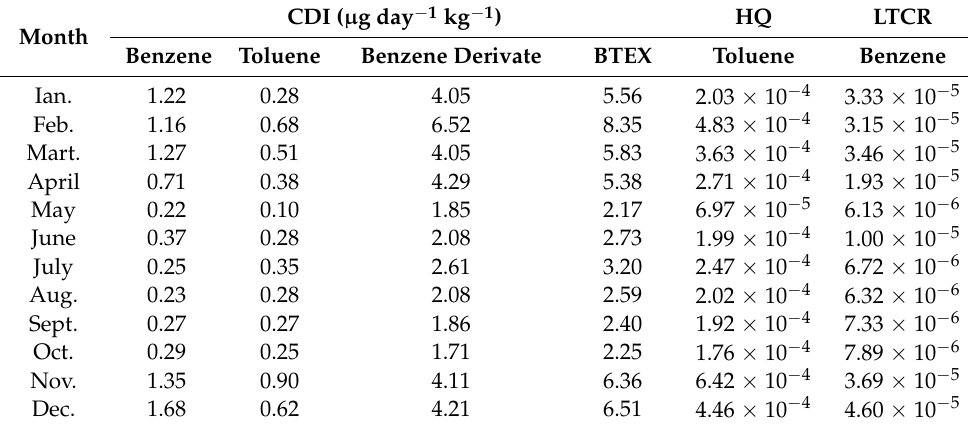
Table 3. Chronic daily intake (CDI), hazard quotient (HQ), and lifetime cancer risk (LTCR) of BTEX determined in Arad City.